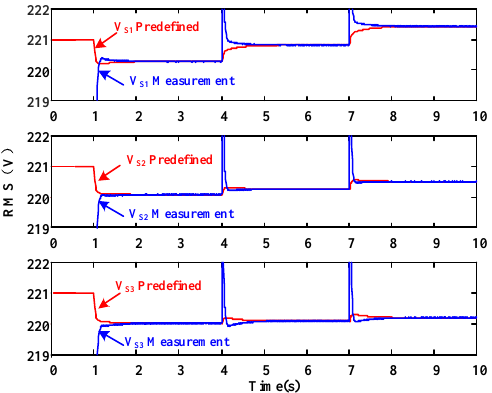
Figure 12. Reference versus measured voltages with the proposed control of multiple ESs.